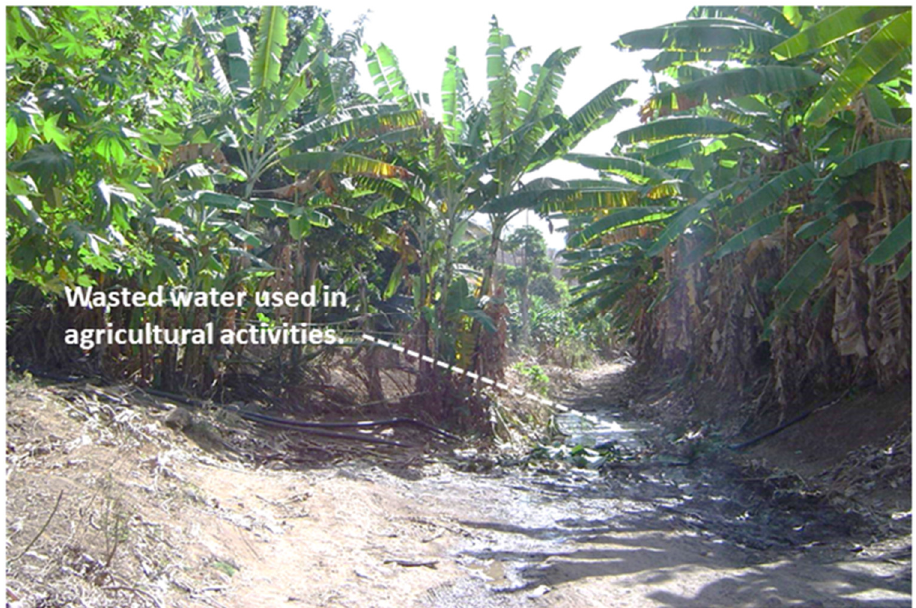
Figure 8. Example of wastewater used in banana field agricultural activities at Santiago Island. The arrow indicates the wastewater in this banana plantation. arrow indicates the wastewater in this banana